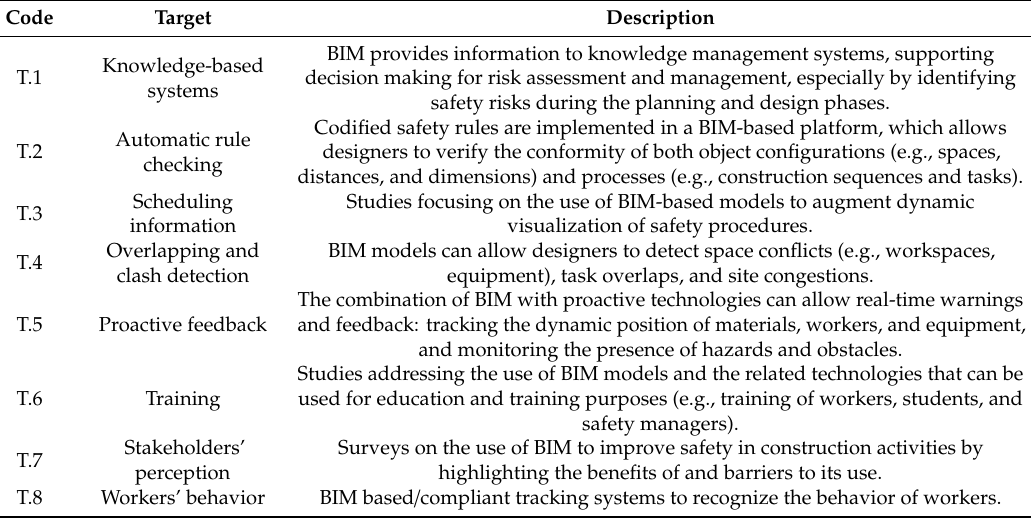
Figure 1. Scheme of the proposed systematic literature review approach. Table 1. Classification of the target types of the selected